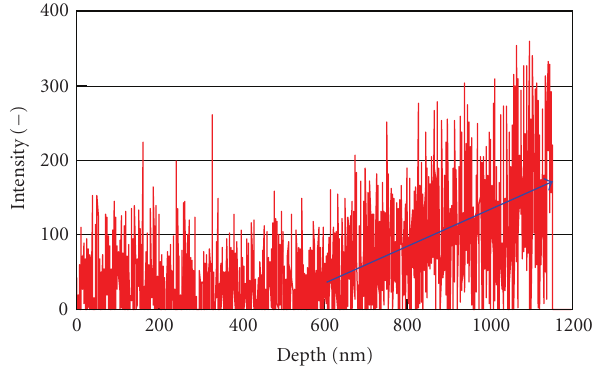
Figure 10: Cu element profile through thickness direction of the Cr-doped TiO 2 film under the condition of N top = 7 by XPS analysis.